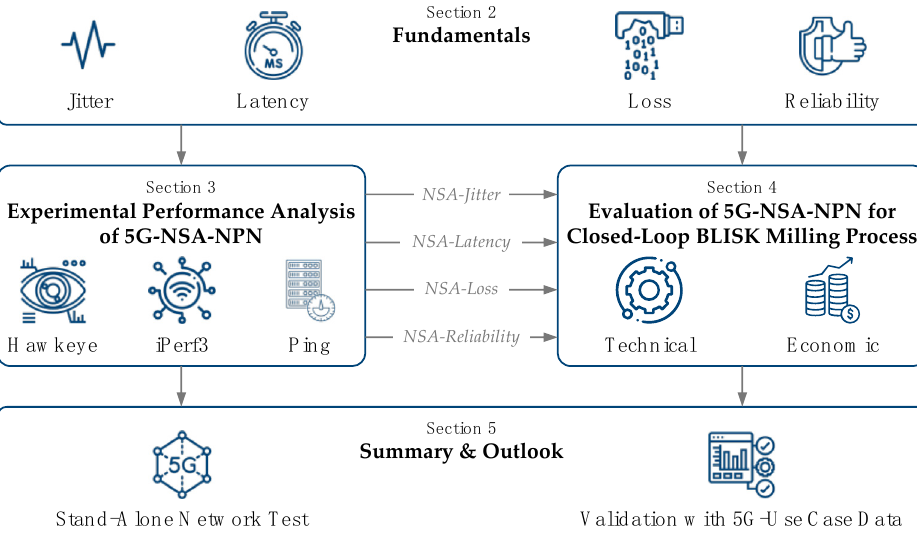
Figure 1. Structure of the paper.